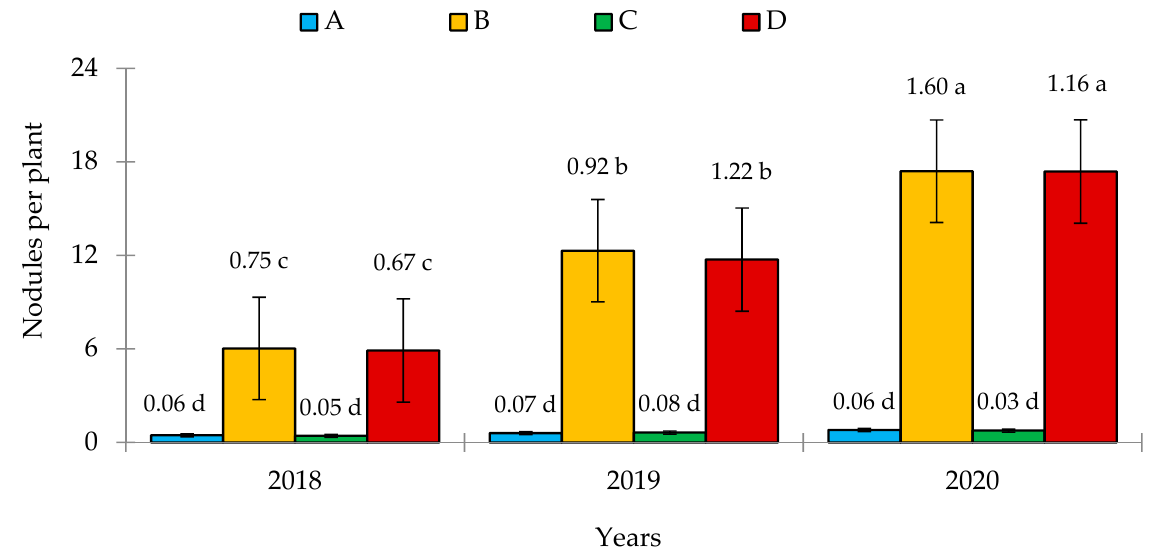
Figure 2. Number of nodules during the flowering stage. A—control (seeds without coating), B— inoculated seeds: HiStick ® Soy, C—coated seeds: chitosan + alginate/PEG, D—B + C. Mean values with different letters (a–d) are statistically different at p < 0.001. The numbers on the bars indicate the standard error (SE).